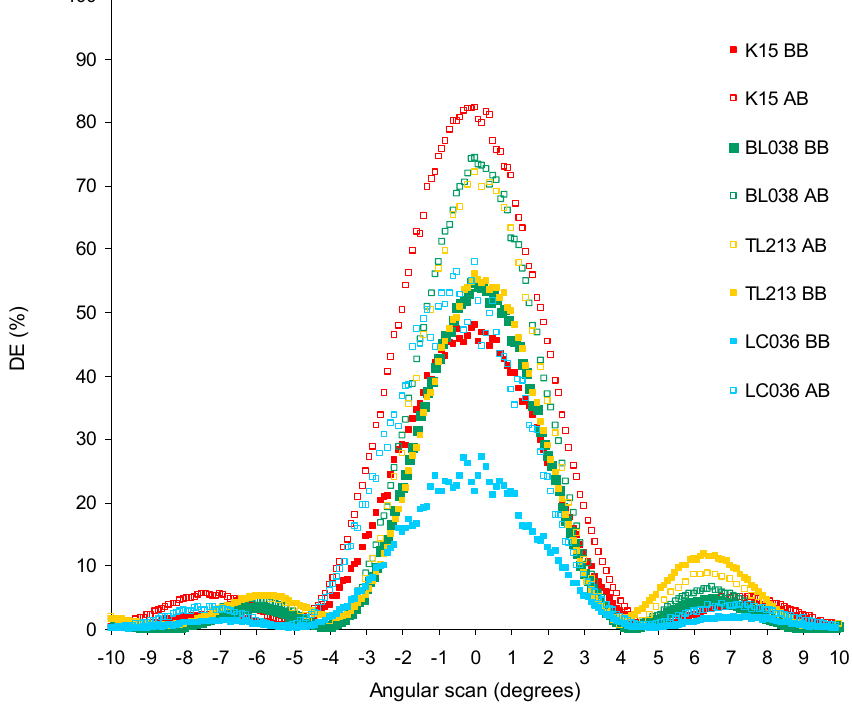
0102030405060708090100 Figure 7. Reconstruction of the hologram before the bleaching process (graphs BB) and after the bleaching process (graphs AB). Figure 8. DEmax divided by the FWHM versus the birefringence of the corresponding LC of each graph in Figure 7.